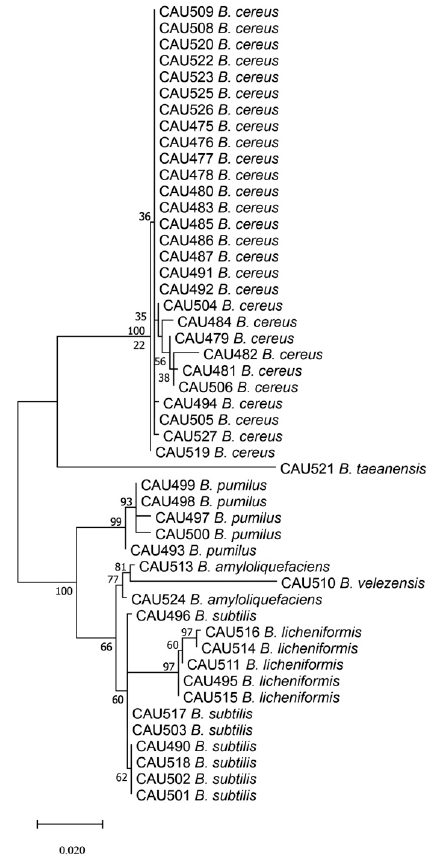
Figure 2. Phylogenetic tree of Bacillus isolates based on 16S rRNA sequences. The tree was con- structed using maximum likelihood method, and genetic distances were generated using Kimura 2-parameter model . The numbers at the branches are bootstrap confidence percentages from 1000 bootstrapped trees.